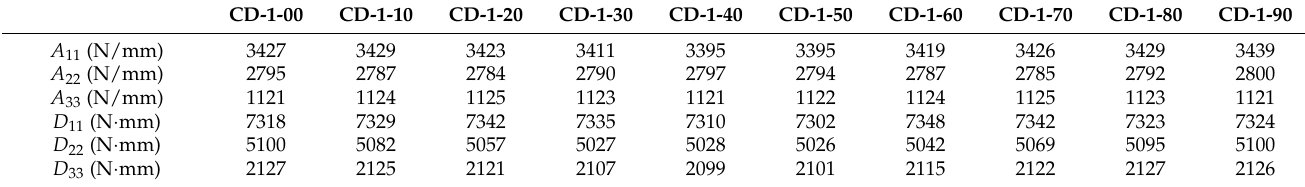
Table 8. The selected stiffnesses with 1% imperfections of compression in the CD shape and with different offsets.